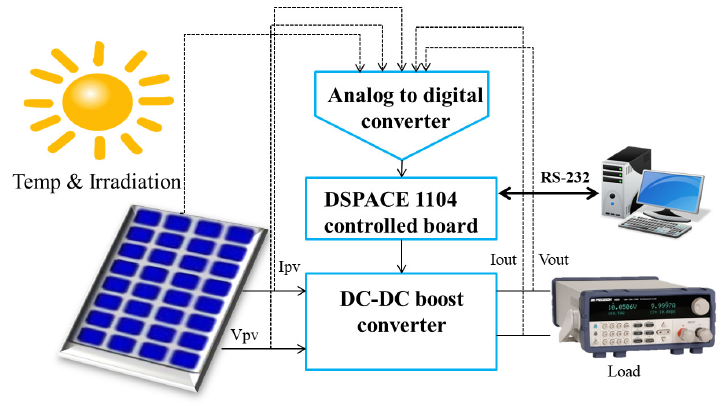
Figure 1. Structure of PV